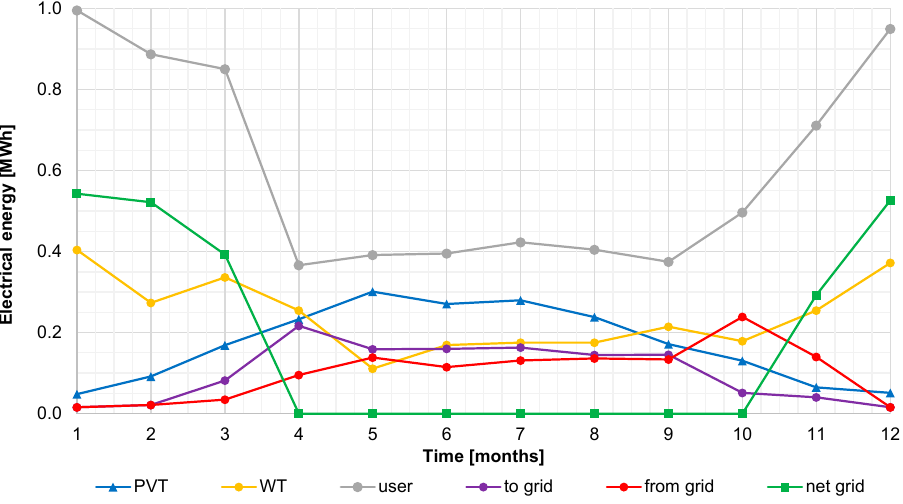
Figure 10. Main electrical energies of the system, monthly analysis.